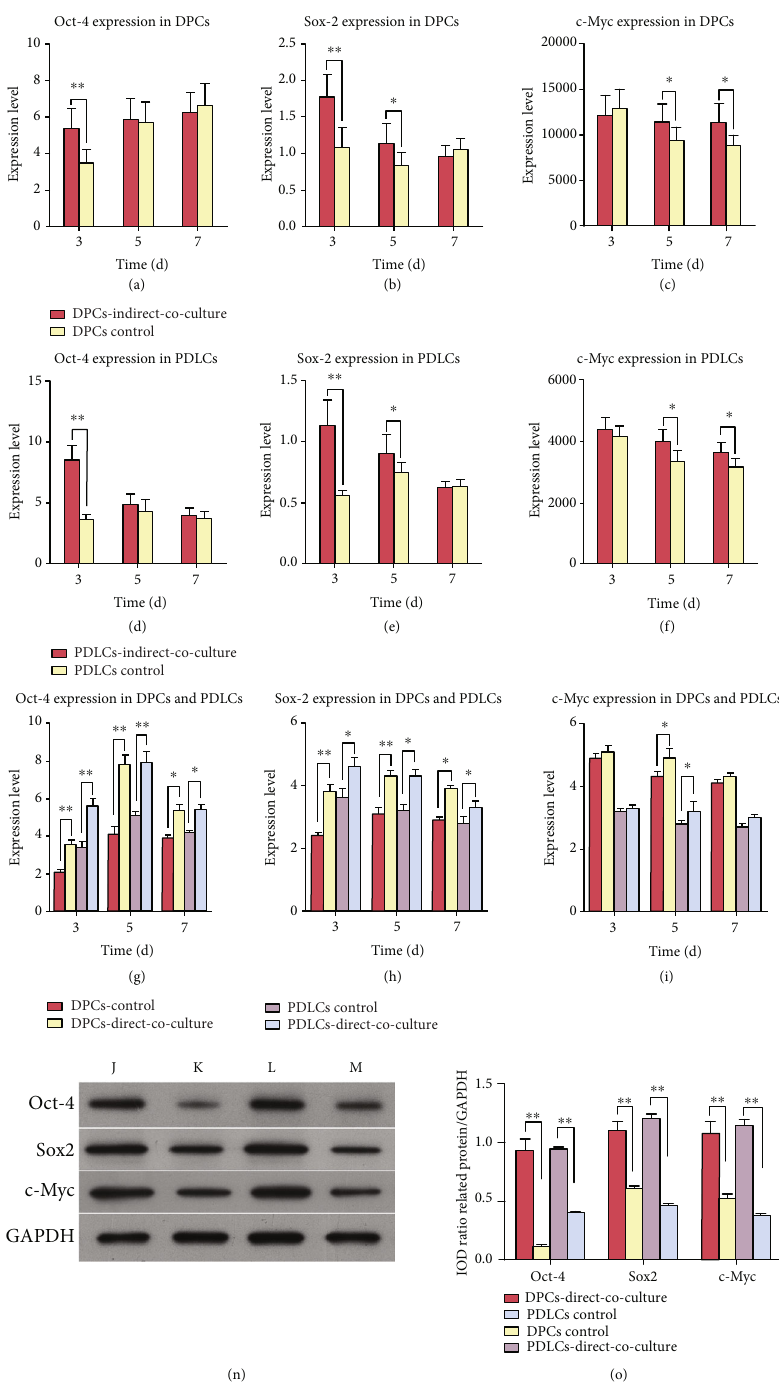
Figure 3: The levels of Oct-4, Sox2, and c-Myc mRNA and protein expression in DPCs and PDLCs with coculture. The levels of Oct-4 (a, d) and Sox2 (b, e) mRNA in DPCs and PDLCs were signi fi cantly upregulated on 3 days of indirect coculture when compared with those levels in the control groups ( ∗∗ P < 0 : 01 ). c-Myc (c, f) expression showed no signi fi cant change in DPCs and PDLCs with indirect coculture until day 5 ( ∗ P < 0 : 05 ). Oct-4 (g) and Sox2 (h) showed similar patterns of expression in DPCs and PDLCs with direct coculture and were signi fi cantly upregulated on days 3 and 5 ( ∗ P < 0 : 05 and ∗∗ P < 0 : 01 ). c-Myc (i) expression showed no signi fi cant change in DPCs and PDLCs with direct coculture until day 5 ( ∗ P < 0 : 05 ). The expression of Oct-4, Sox2, and c-Myc proteins was strongly enhanced in DPCs and PDLCs with direct coculture (n, o). (j) DPCs with direct coculture. (k) DPCs control. (l) PDLCs with direct coculture. (m) PDLCs